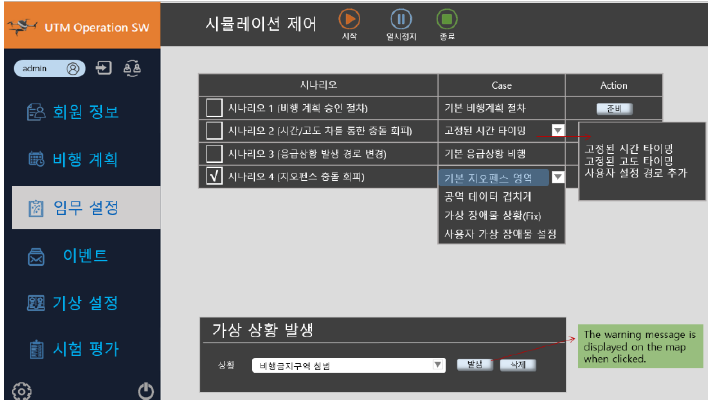
Figure 5. UOS UI—simulation control window.